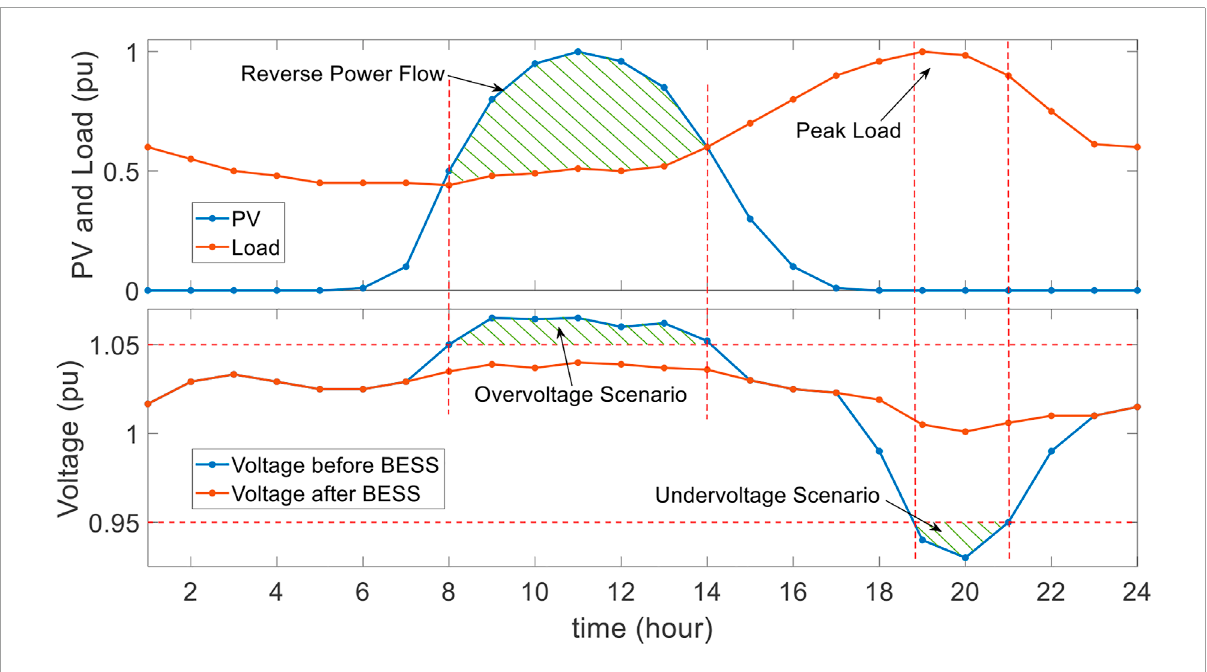
FIGURE 4 Typical application of BESS for mitigating overvoltage and under voltage